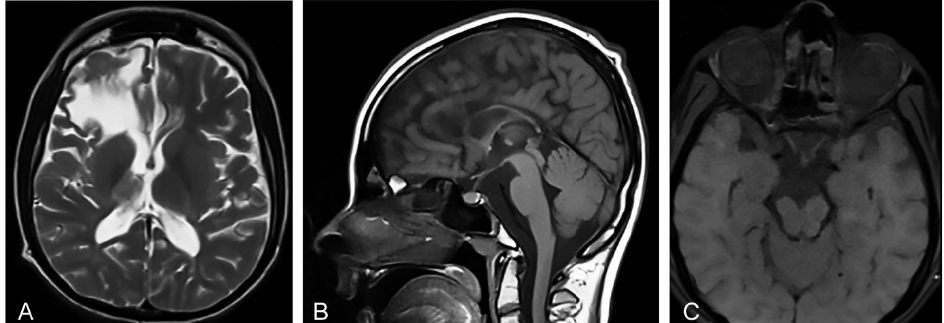
Figure 1. ( A ) Proband’s axial T2-weighted Magnetic resonance image (MRI) at the age of 20 shows abnormalities in supratentorial white matter and thalamus, and a porencephalic cyst in the right frontal lobe with the compression on the right lateral ventricle. ( B ) Proband’s sagittal T1-weighted MRI shows microcephaly and hypoplasia of the corpus callosum secondary to white matter loss. ( C ) Proband’s axial T1-weighted MRI shows an atrophy of the optic nerves, optic tracts, and optic chiasm.